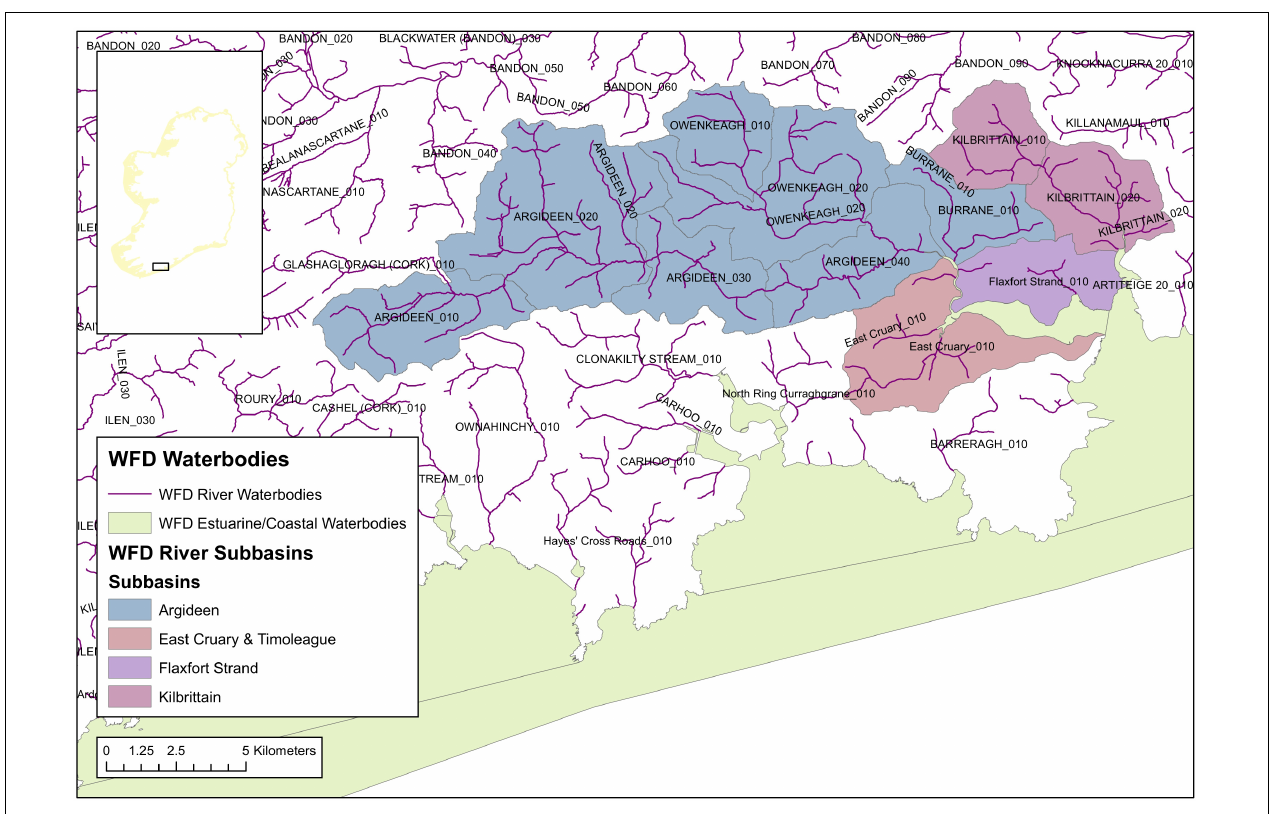
FIGURE 3 | The subbasins which drain to the Argideen Estuary and Courtmacsherry